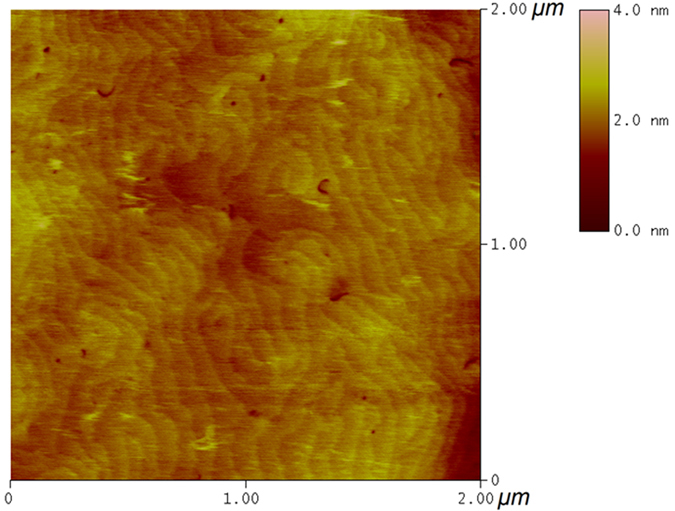
AFM image of the final Al0.5Ga0.5N surface of the DBR corresponding to a 2 × 2 μm2 area.